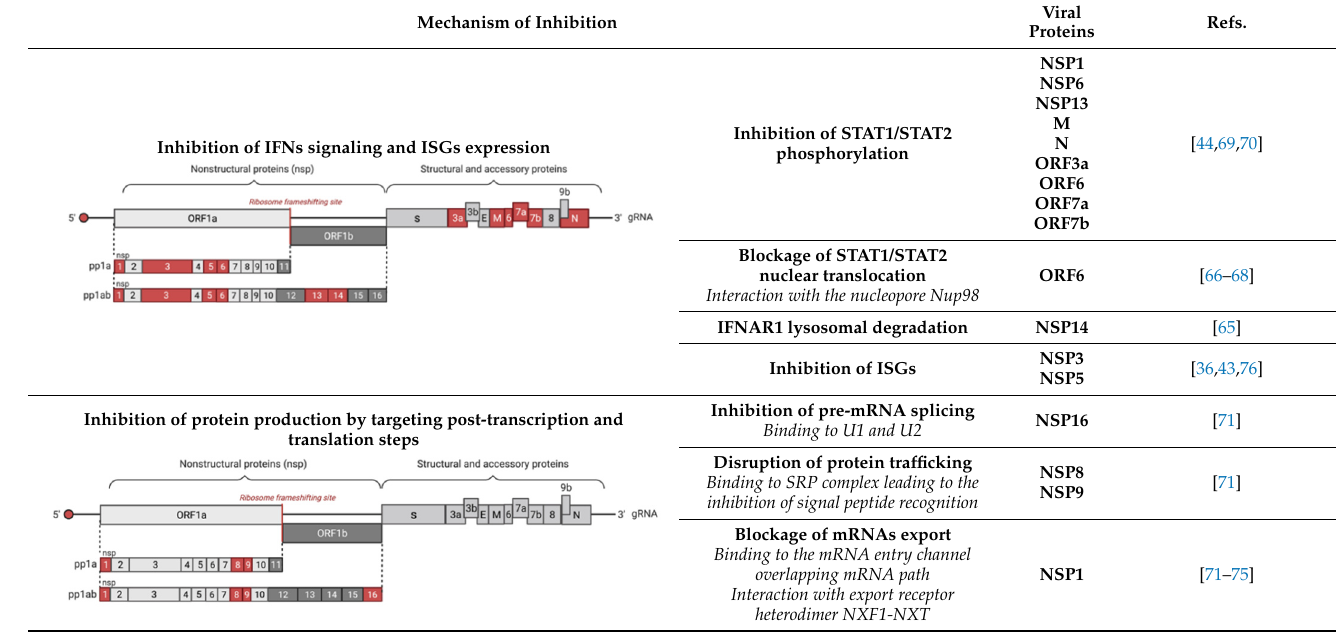
Table 1. Cont. Mechanism of Inhibition Viral Proteins